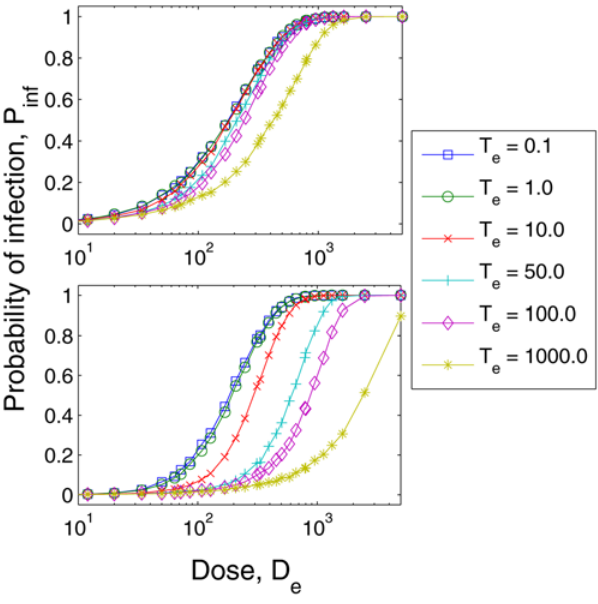
Figure 8. Predicted effects of varying exposure times ( T e ) when inoculated with Cryptosporidiumparvum. The top graph comes from simulations using the parameter set defined in Figure 5. The bottom graph comes simulations using the parameter set R ~ h p , d p , a i , c i , d i , l i